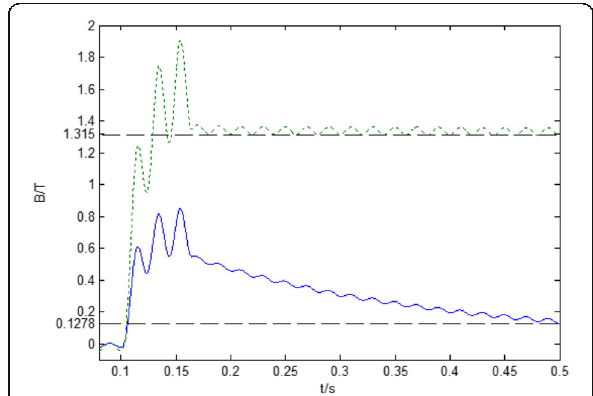
Fig. 18 Remanence comparison of iron cores in CT after fault